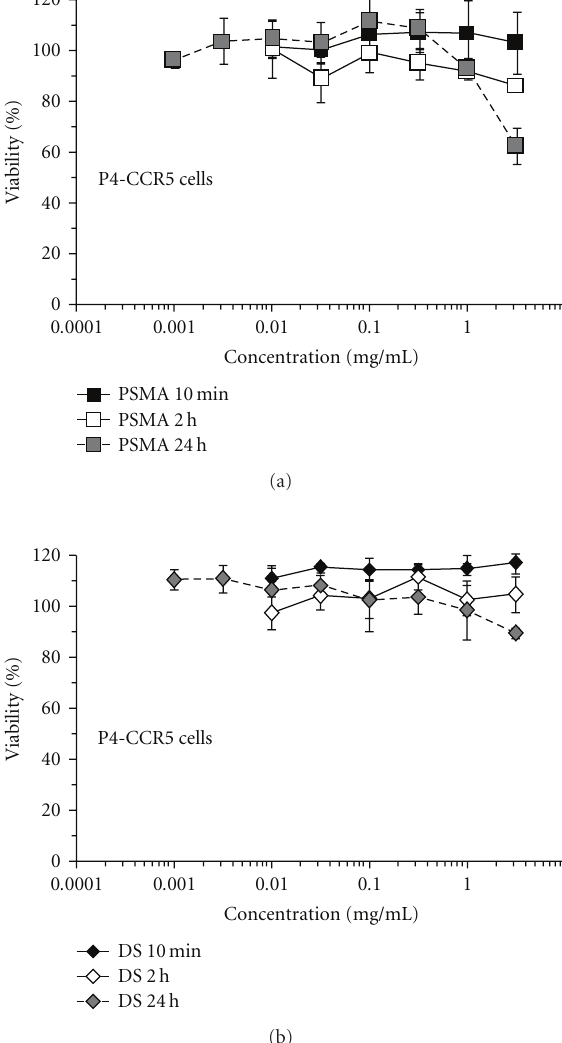
Figure 4: alt -PSMA has low in vitro cytotoxicity similar to DS. P4- R5 MAGI cells were exposed (or mock-exposed) to the indicated concentrations of (a) alt -PSMA or (b) DS for 10min, 2 h, or 24 h. Following the exposure period, cells were washed and assessed for viability using an MTT assay (as described in Section 2). Results illustrated are from two independent assays in which each concentration was examined in